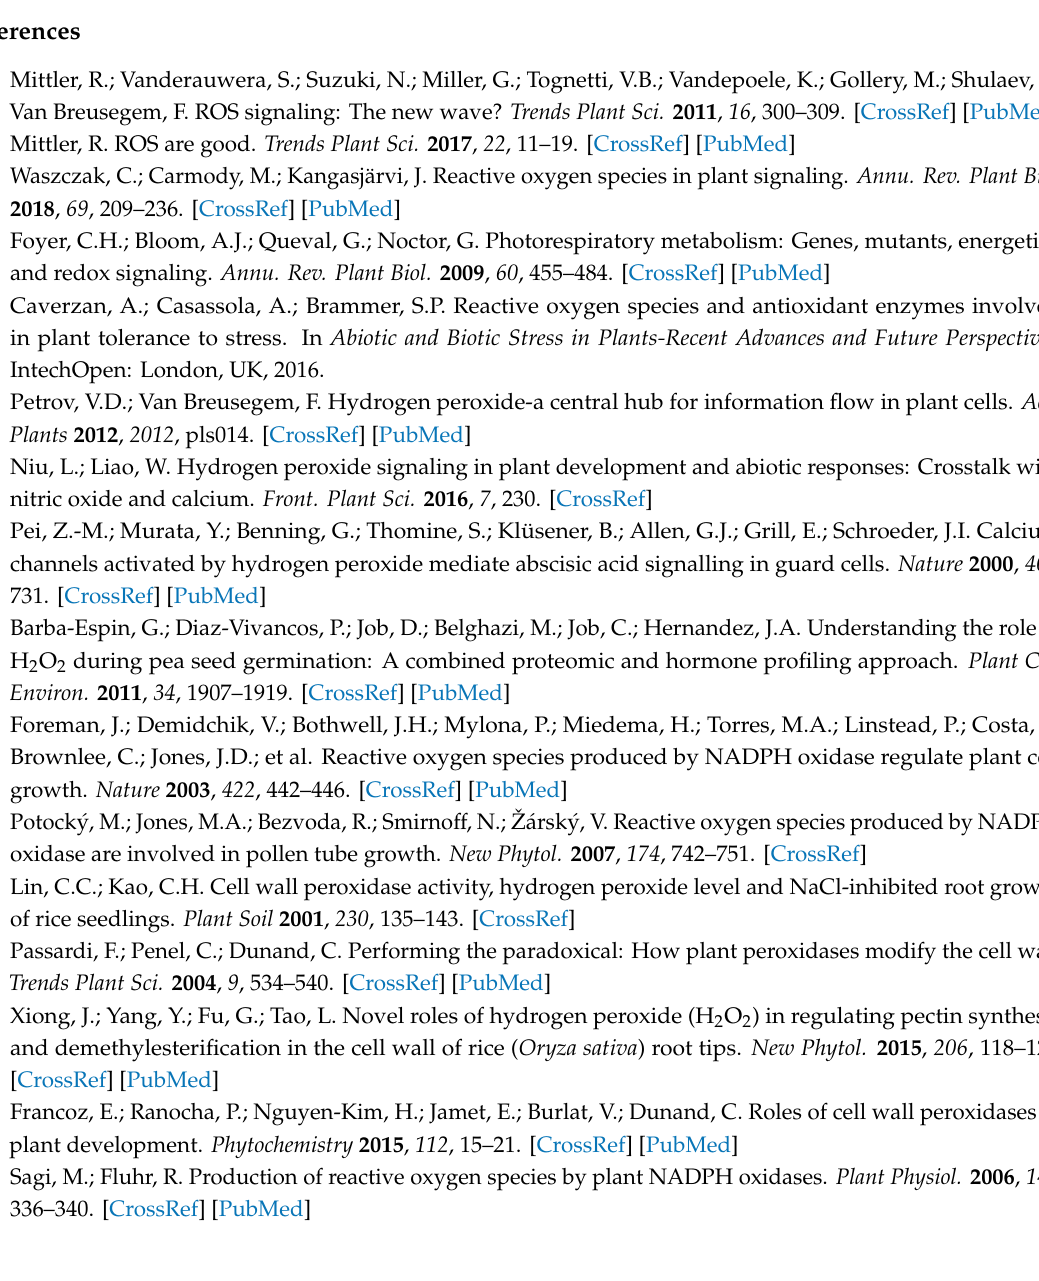
Supplementary Figure S1: E ff ect of 0.1% methanol on Arabidopsis thaliana cell suspensions viability. Supplementary Figure S2: Induction of cell death in response to thaxtomin A, H 2 O 2 , and a combination of